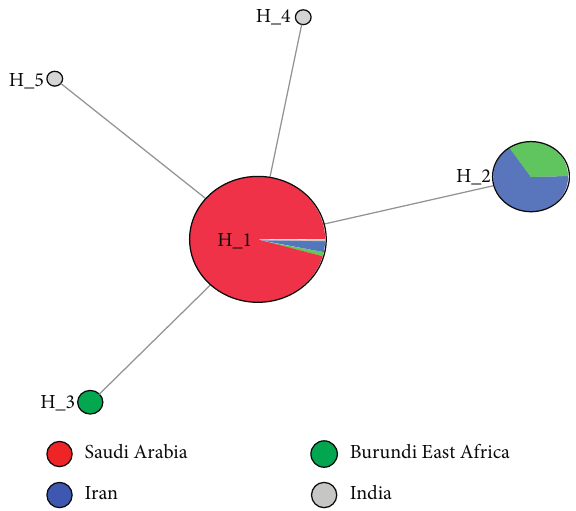
Figure 2: PfKAHRP haplotype network generated from 4 different countries. The size of the circles representing each haplotype is proportional to the number of sequences that correspond to this haplotype. Distances between nodes are